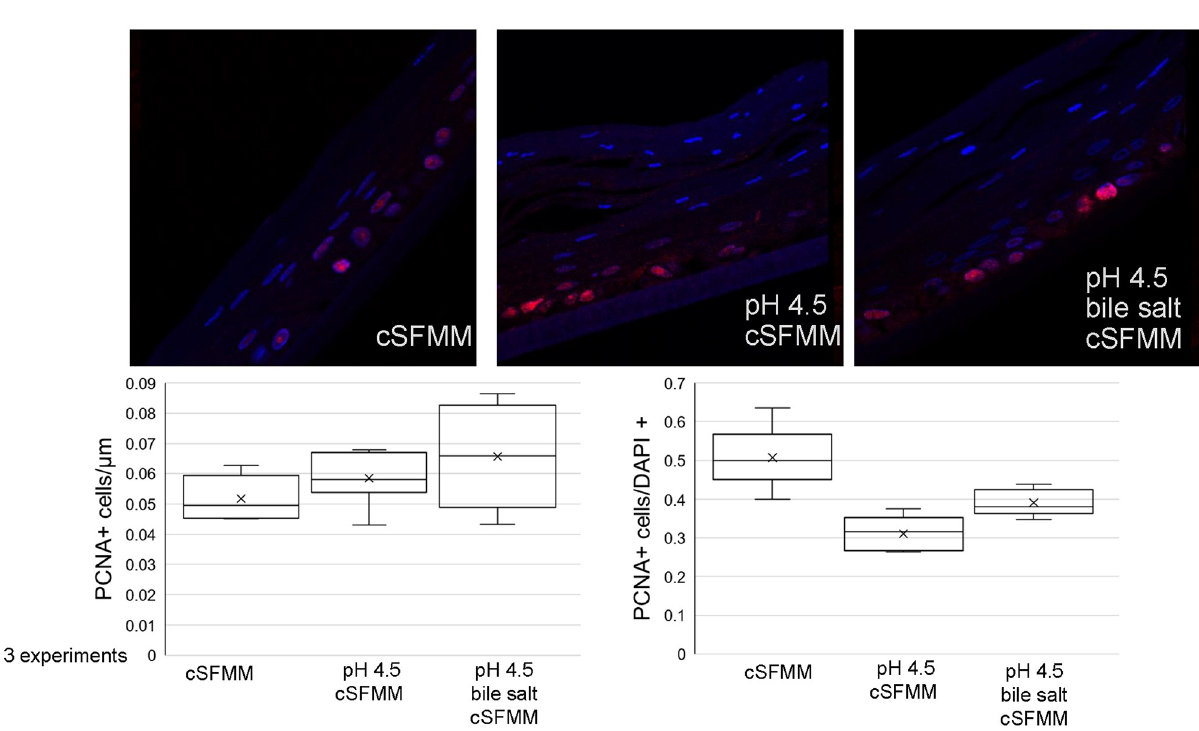
Fig 4. Proliferative marker PCNA expression in the squamous epithelium in 3D OTC-ALI in response to conditioned media from untreated, pH4.5 and pH4.5 bile salt treated HEMFs conditioned media. PCNA immunostaining (pink/red) is limited to the lowest layer cells in the squamous epithelium established with conditioned media from untreated, pH4.5 treated, and pH4.5 bile salt treated HEMFs. Quantification of PCNA + cells per μ m of tissue length and per DAPI+ cells are shown in the graphs. Quantification of PCNA per μ m of tissue length is similar across all conditions. Quantification of PCNA per DAPI+ cells demonstrates a decrease in PCNA expression in epithelial cells established with conditioned media from pH 4.5 and pH 4.5 bile salt treated HEMFs vs untreated HEMFs. Box and whisker plot of data from three independent experiments is shown (minimum, maximum, lower and upper quartile, and median are shown in the box and whisker plot). Mean values are indicated by